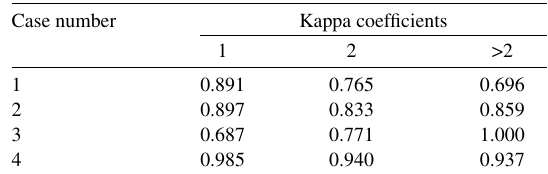
The computed Kappa coefficients for agreement between the CAD scheme and the observer in analyzing the four testing